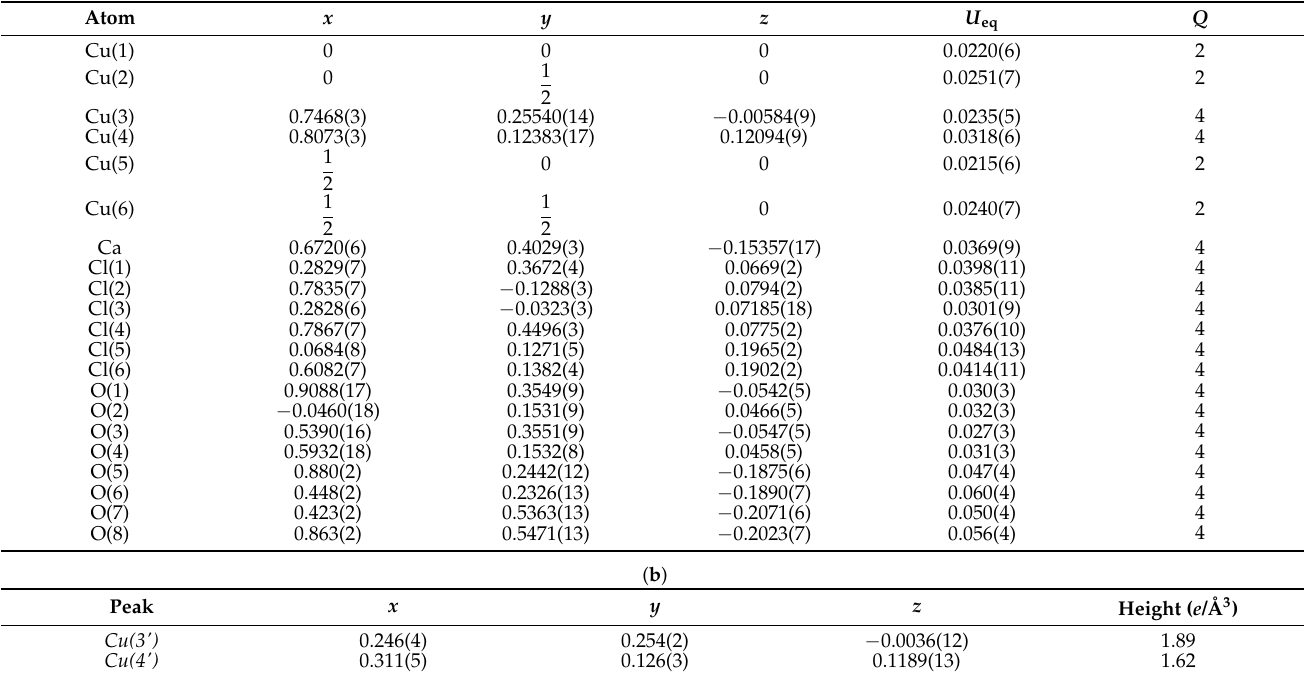
Table 4. ( a ) Coordinates, equivalent displacement parameters ( U eq , in Å 2 ) of atoms and site multiplicities ( Q ) for dioskouriite- 2 M ; b Residual peaks related to dioskouriite-2 O in the difference Fourier map of dioskouriite-2 M.